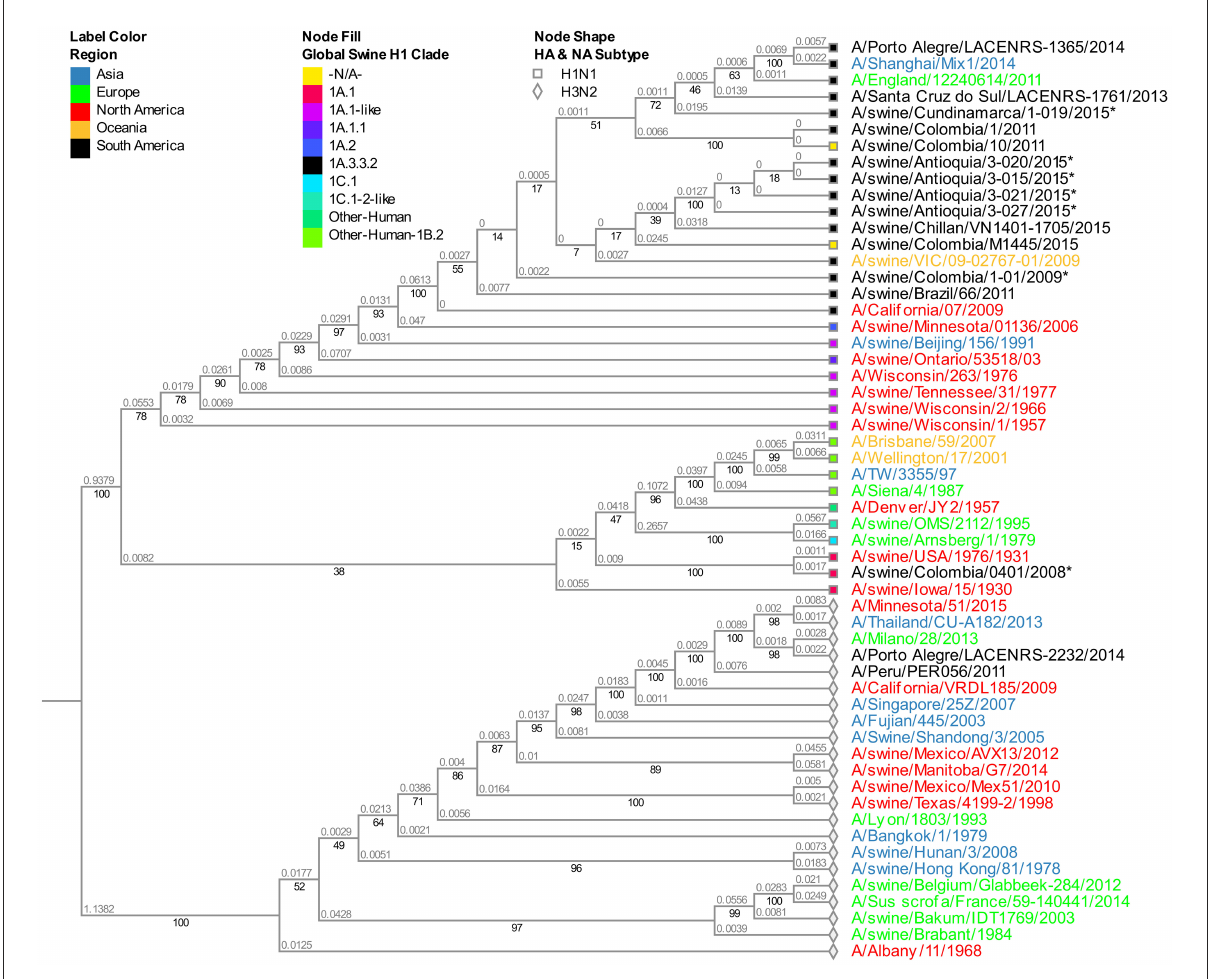
FIGURE1 Phylogenetic analysis for HA gene of swine influenza A virus. Phylogenetic tree was generated using RAxML program for maximum likelihood-based inference. The reliability of the trees was inferred by bootstrap analysis with 1,000 replications. The tree was constructed with representative sequences from human and swine of H1N1 classical and H1N1pdm09 and human and swine H3N2. Colombian isolates included on this study are labeled with